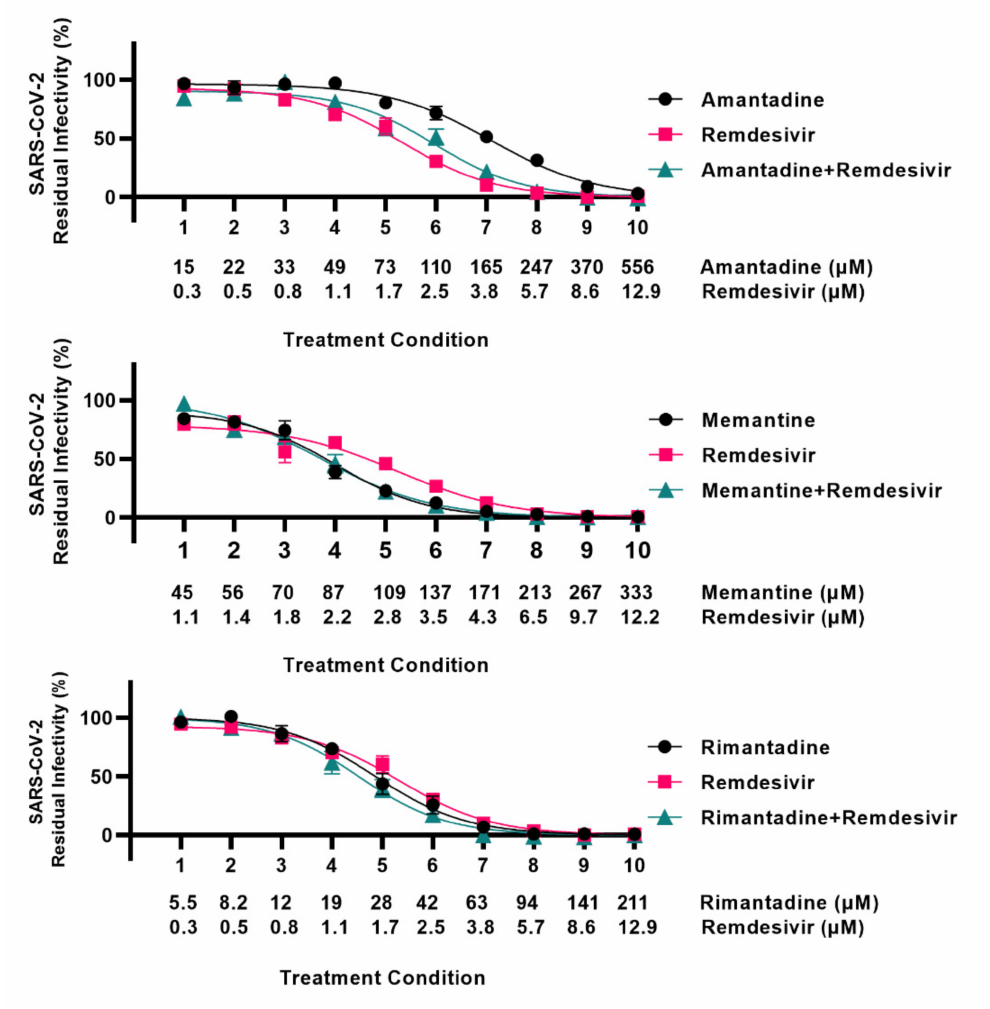
Figure 2. Analysis of interactions of adamantane derivatives with remdesivir in VeroE6 cells. VeroE6 cells seeded in 96-well plates were infected with SARS-CoV-2 and treated with serial dilutions of amantadine, memantine, rimantadine, or remdesivir, or a combination of these ion-channel inhibitors and remdesivir. SARS-CoV-2 infected cells were visualized by immunostaining for spike protein and quantified by automated counting. For each inhibitor pair to be evaluated, the treatment conditions indicated on the x-axis were applied. Each treatment condition was defined by a specific concentration of ion-channel inhibitor singly, a specific concentration of remdesivir singly, and a combination of these same concentrations of ion-channel inhibitor and remdesivir as indicated, resulting in three datapoints per treatment condition. Datapoints are means of counts from seven replicate cultures ± SEM and represent % residual infectivity, determined as % SARS-CoV-2 positive cells relative to means of counts from infected-nontreated control cultures. Sigmoidal concentration- response curves were fitted and EC50 values were determined using Graphpad Prism 8.0.0 applying the formula Y = Top/(1 + 10 (Log10EC50-X)*HillSlope ). The tested inhibitor concentrations did not affect cell viability (Figure